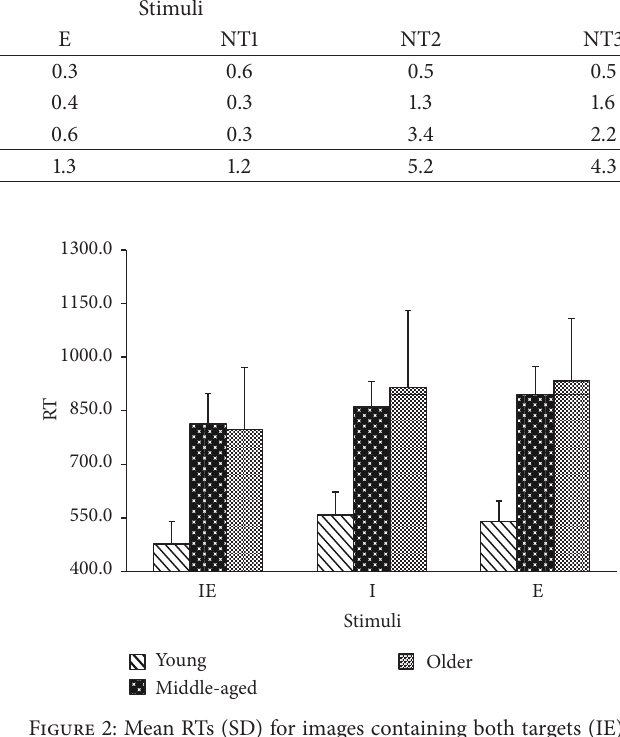
Figure 2: Mean RTs (SD) for images containing both targets (IE), the identity target (I), and the emotional expression target (E), for groups of young, middle-aged, and older